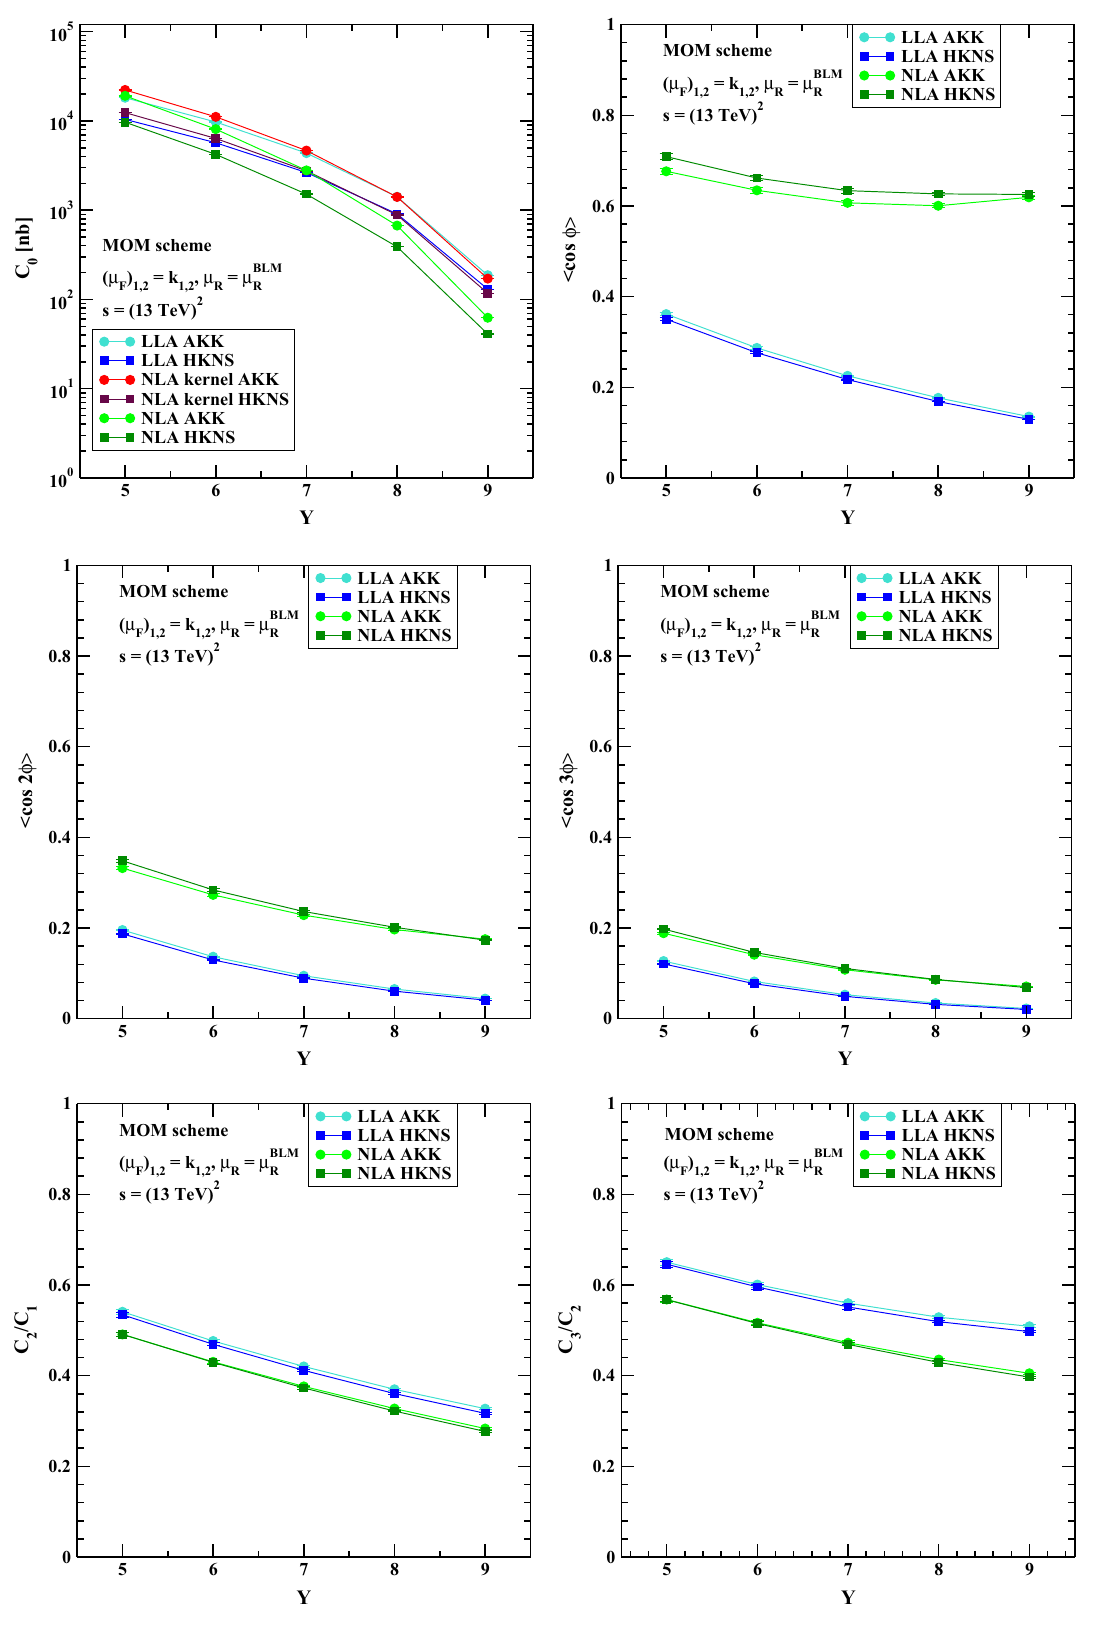
Fig. 10 Y -dependence of C 0 and of several ratios C m / C n for (μ F ) 1 , 2 = |(cid:6) k 1 , 2 | ,